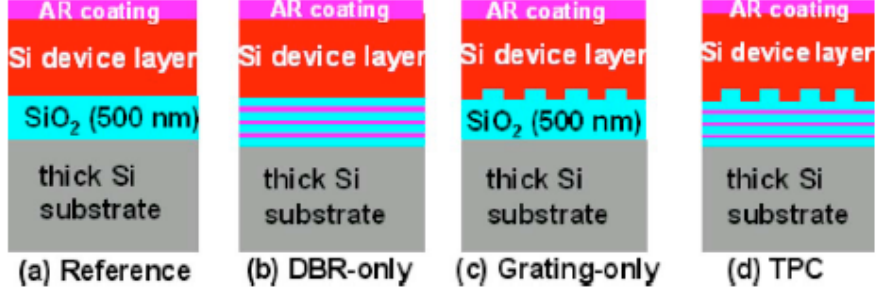
Figure 3. Schematics of thin-film silicon SCs with different back structures: (a) without any design for reference, (b) DBR only, (c) Grating-only, (d) textured PC (TPC) (reprinted with permission from [22]. © 2008, American Institute of Physics).